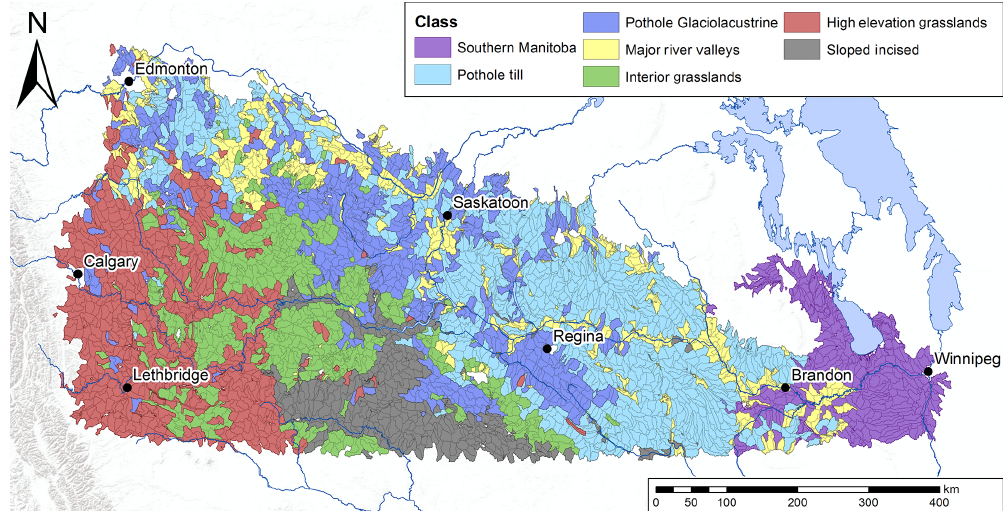
Figure 5. Classification of Prairie ecozone watersheds. Watershed delineations are from Lehner and Grill (2013), available at https://www. hydrosheds.org/ (last access: 11 August 2018). See text for detailed interpretation of the seven